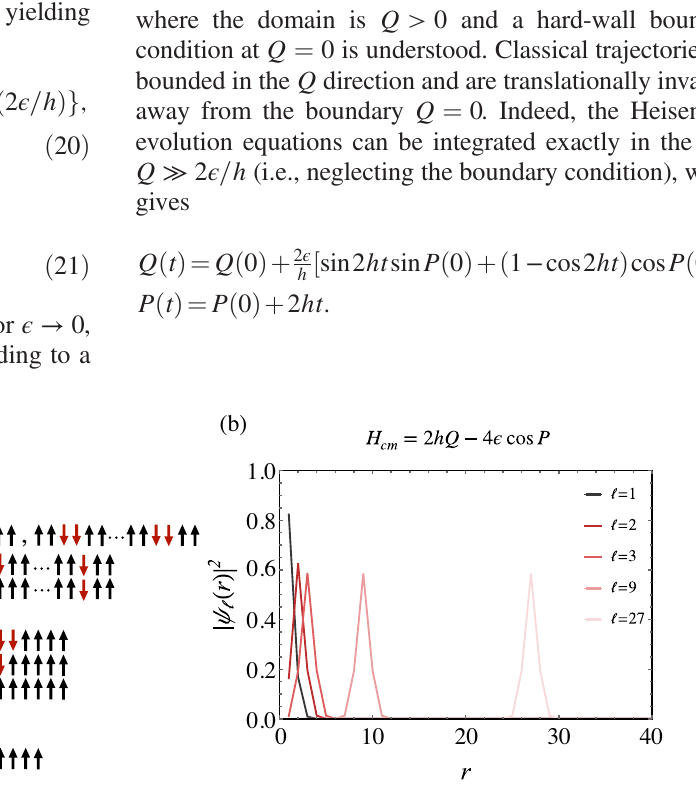
FIG. 4. (a) Sketch of the low-energy spectrum of the Floquet operator in Eq. (16) for ϵ → 0 . The vertical axis represents the relative eigenphase Δ E with respect to the polarized state jþi . (b) Selection of mesonic eigenfunctions of the two-body problem, cf. Eq. (21), for ϵ =h ¼ 1 . 5